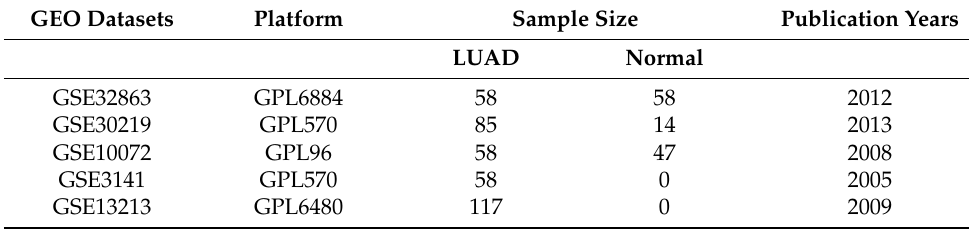
Table 1. The main features of the five selected datasets used in this study. GEO